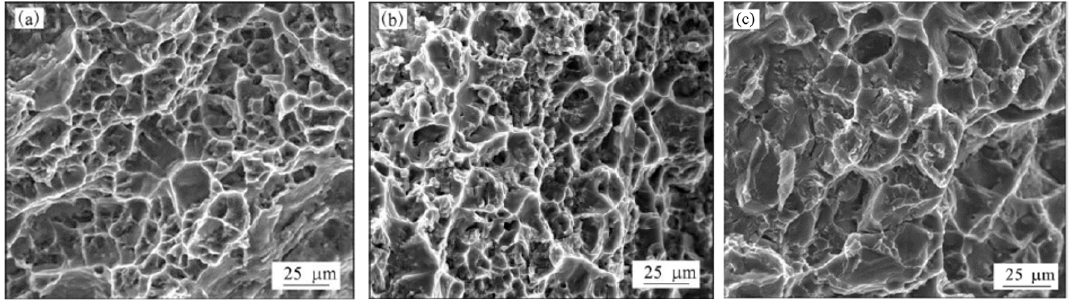
Figure 9. SEM micrographs of tensile fracture for samples produced under different processing conditions: ( a ) Rheo-HPDC; ( b ) conventional HPDC, and ( c ) conventional GC [69].